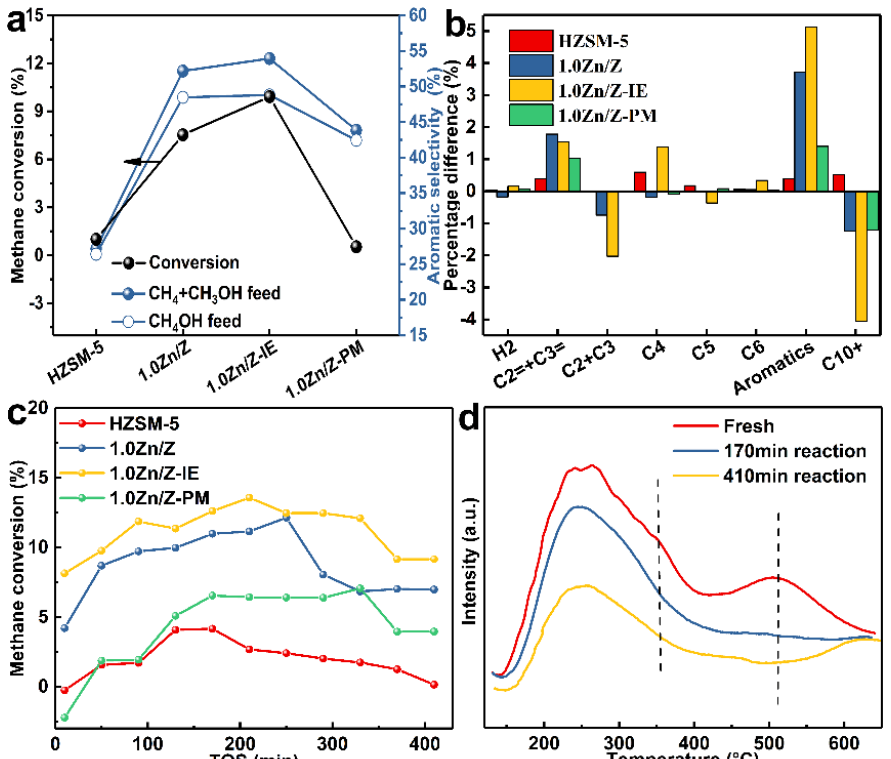
Figure 5. Methane conversion and BTX selectivities of MTA and co-reaction over HZSM-5 and ZSM-5 samples by different Zn-loading strategies (0.67 g catalyst, 37.1 mL·min −1 N 2 flow rate in MTA reaction or 37.1 mL·min −1 mixed gas of N 2 and CH 4 , 0.045 mL·min −1 methanol flow rate, the methanol to methane molar ratio is 1.3, average data calculated by performance at 10 min, 50 min, 90 min) ( a ); difference of product distribution between co-reaction and MTA reaction over HZSM-5 and ZSM-5 samples by different Zn-loading strategies ( b ); methane conversion of co-reaction over HZSM-5 and ZSM-5 samples by different Zn-loading strategies with time on stream ( c ); NH 3 -TPD curves of 1.0Zn/Z before reaction, after 170 min and 410 min reaction ( d ).